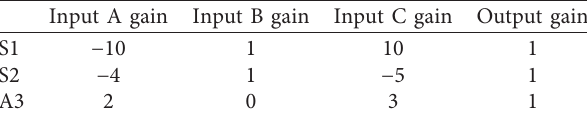
Table 1: The input/output gains of the